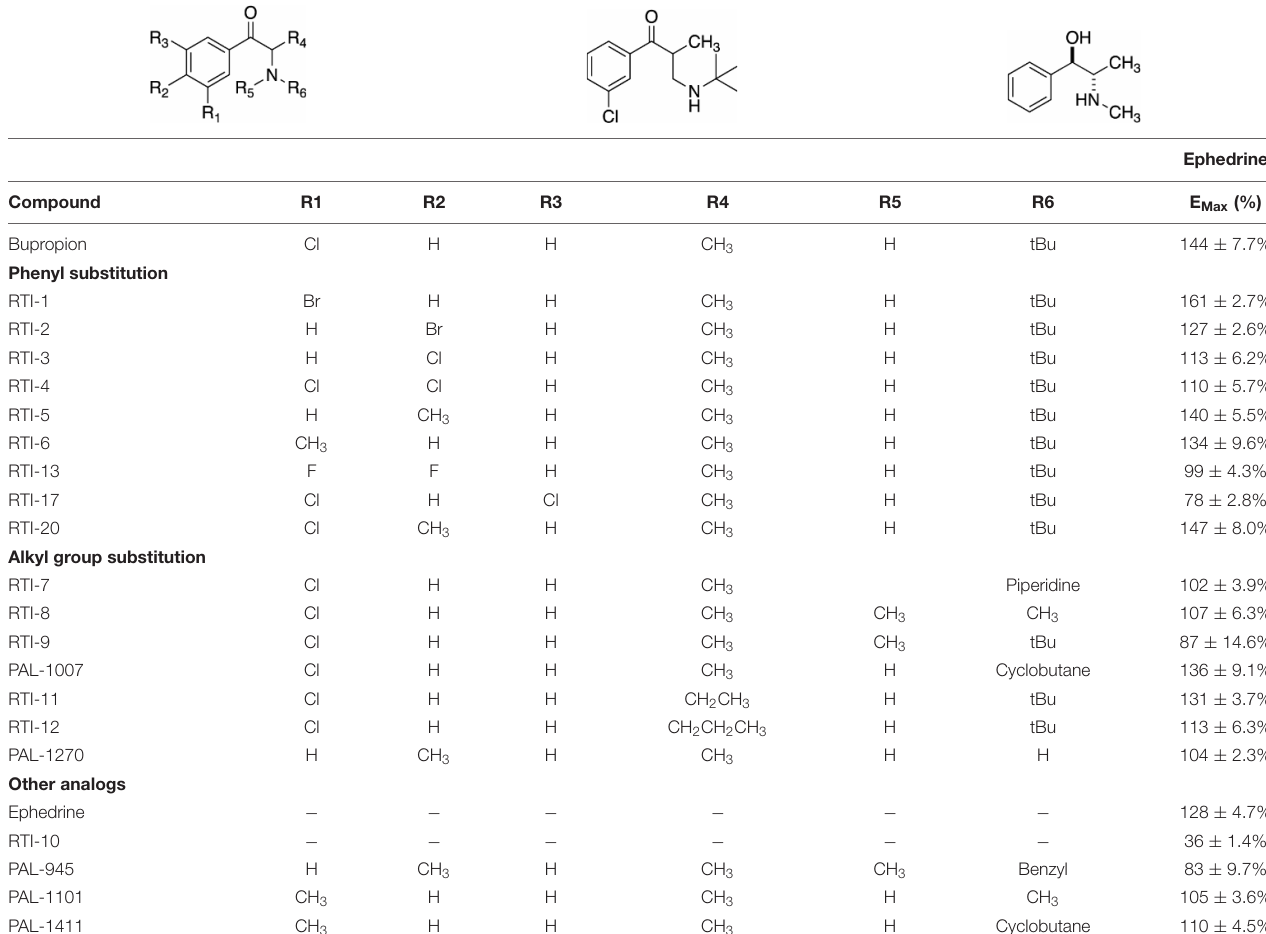
TABLE 1 | Select bupropion